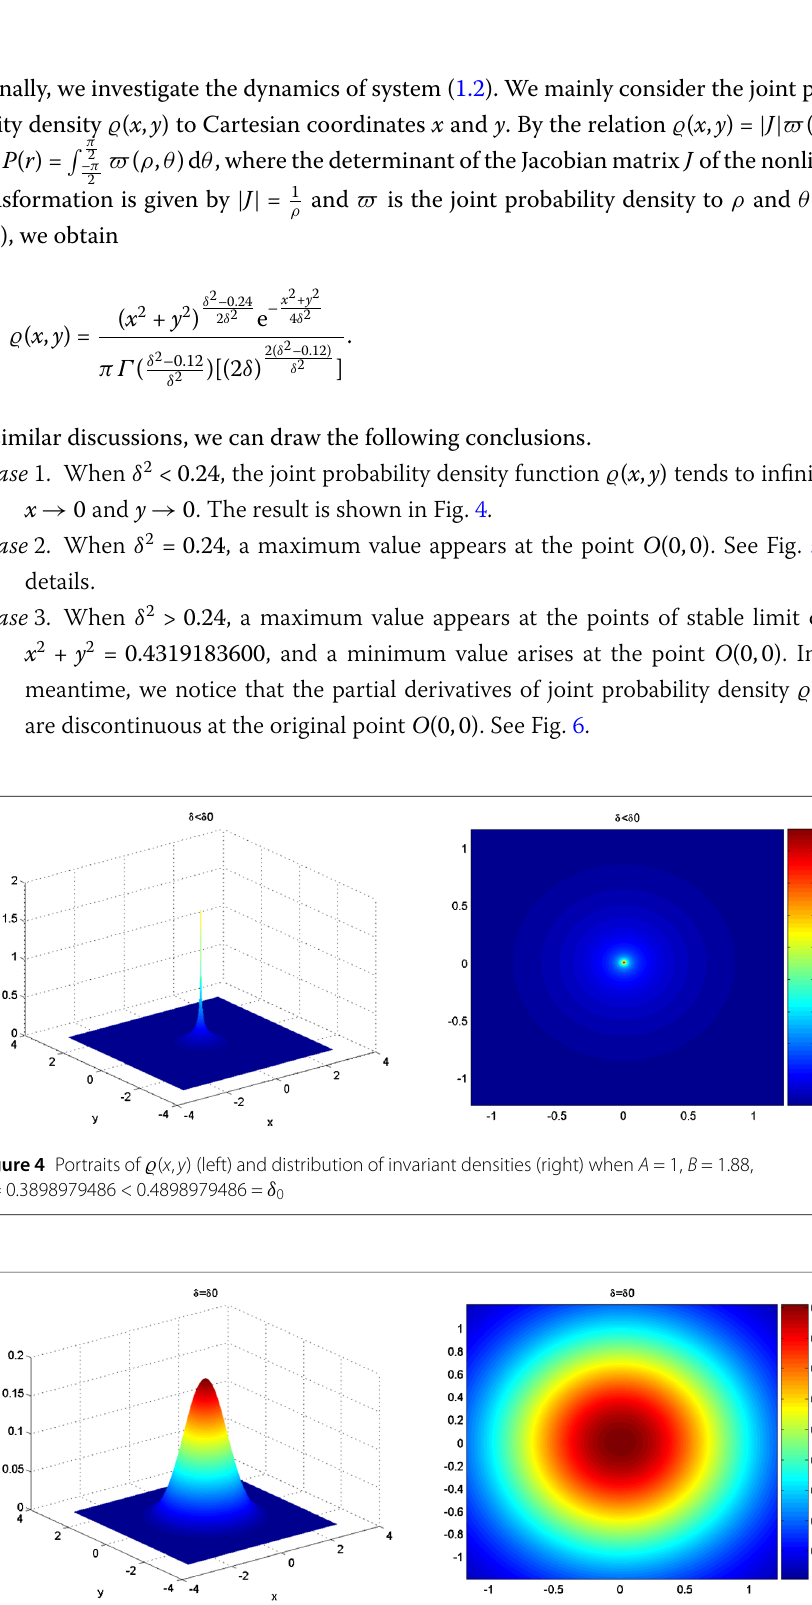
Figure 5 Portraits of (cid:21) ( x , y ) (left) and distribution of invariant densities (right) when A = 1, B = 1.88, δ = 0.4898979486 =